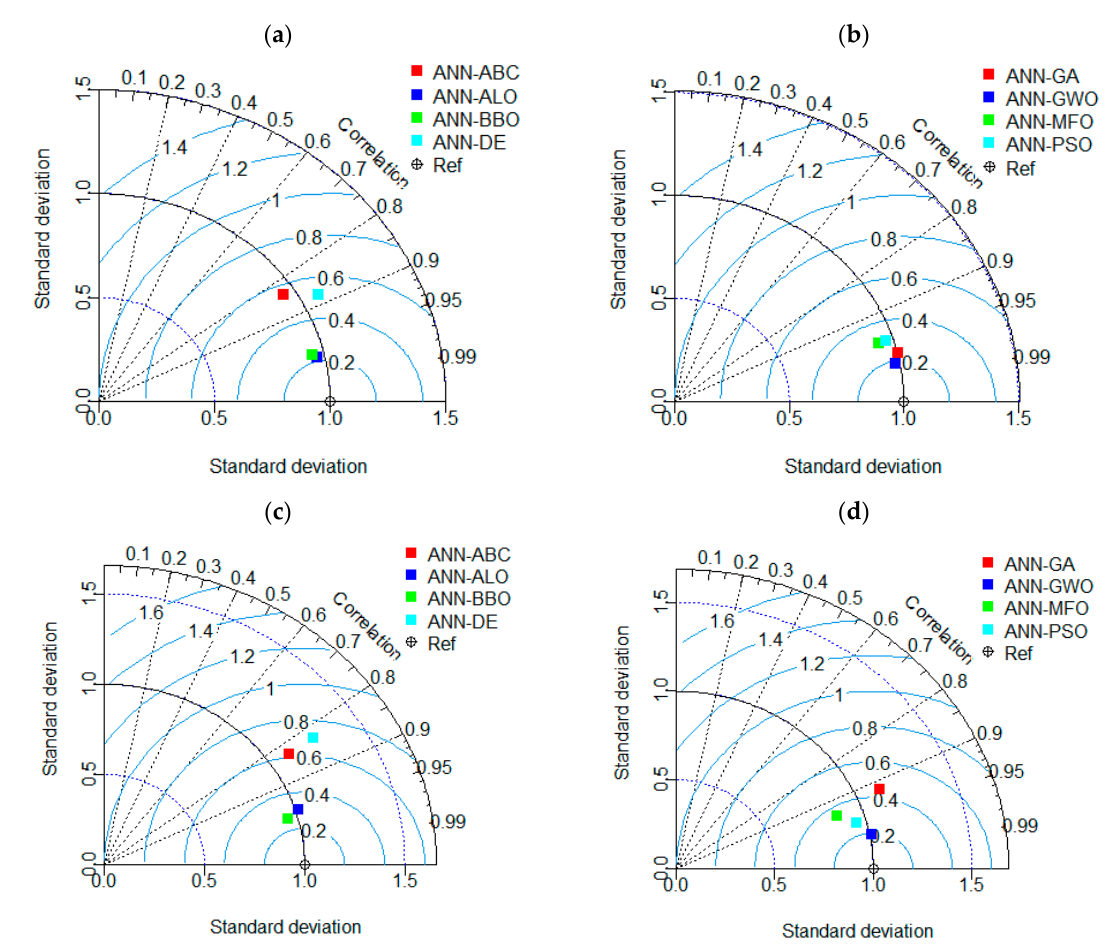
Figure 12. Taylor diagrams for the ( a , b ) training phase and ( c , d ) testing phase.